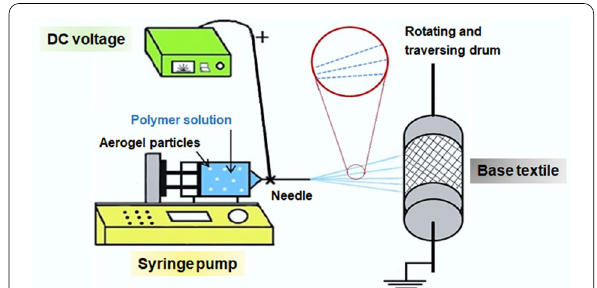
Fig. 8 Schematic design for the basic setup of the electro-spraying device [80] Copyright 2019 Surface and Coatings